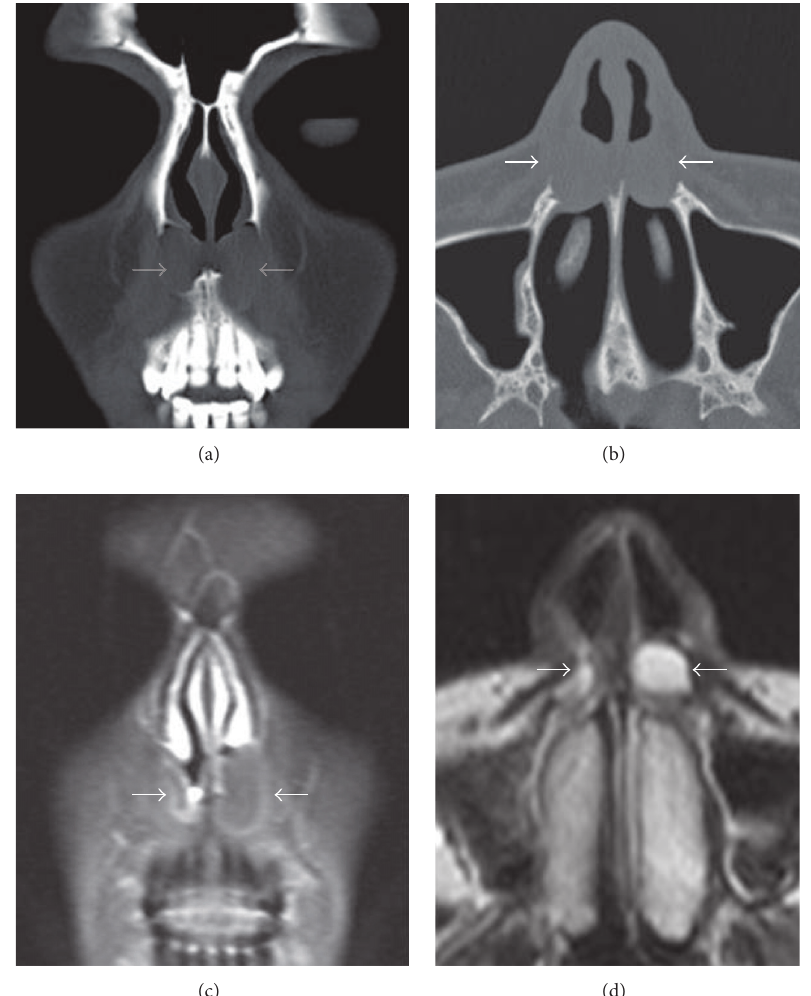
Figure 1: In the CT imaging of the maxillary bone, in both nasal vestibule floors, properly limited hypodense cystic lesions were observed, whichweremeasured tobeapproximately2cmin theleft and 1cm intheright((a)coronalview,(b) axial view).In theMR imaging performed after the antibiotherapy, at the same location, there were observed properly limited cystic lesions that did not show contrasting and looked hypointense at T1 display and hyperintense at T2 display ((c) coronal view, (d) axial